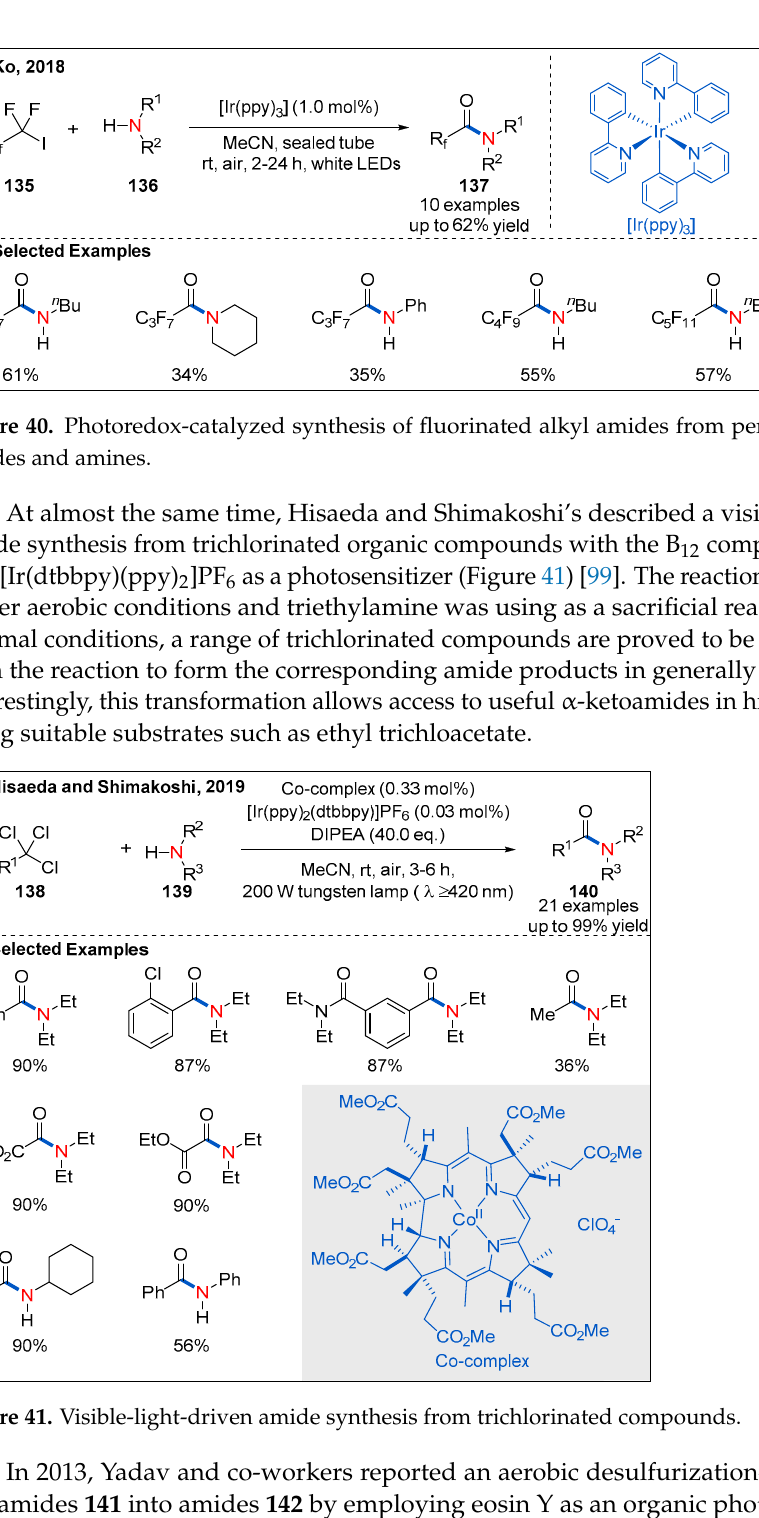
Figure 42. Visible-light-driven aerobic desulfurization–oxygenation of thioamides. In 2013, Li and co-workers reported a visible-light-mediated radical addition reaction between N,N -dimethylaniline derivatives 143 and isocyanates 144 (Figure 43) [101]. After screening